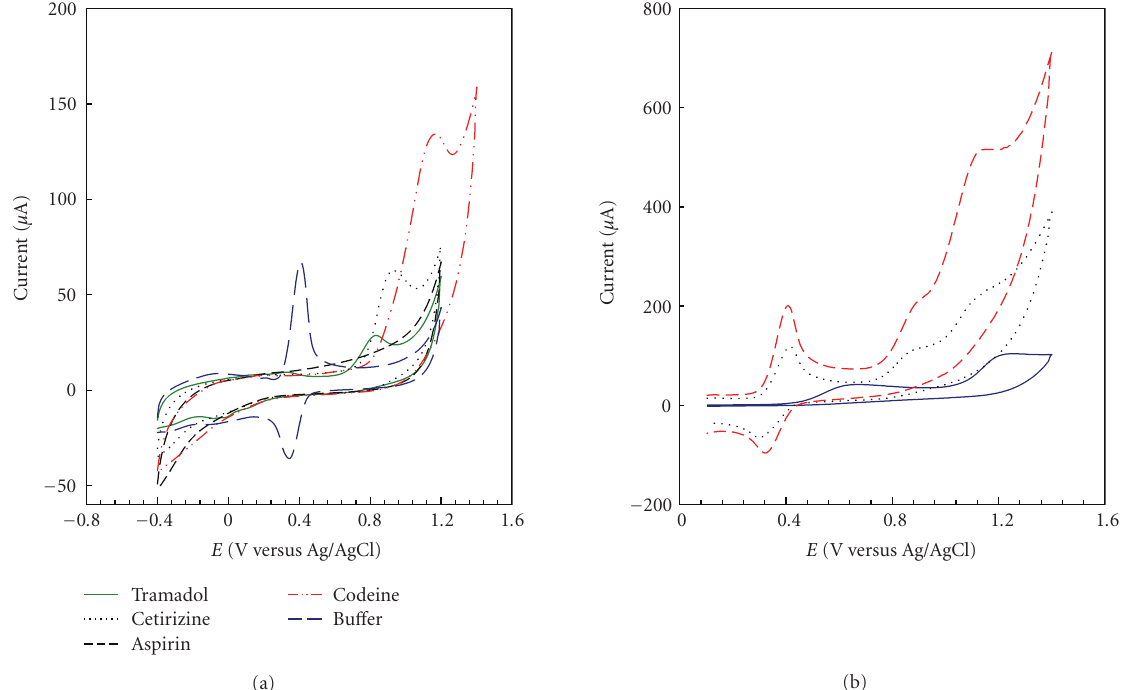
Figure 7: Cyclic voltammograms of (a) 0.1 mM of several drugs: tramadol, cetirzine, aspirin, codeine, and AC on the surface of oppy/MWCNT/GCE, (b) mixture solution containing 1mM of AA, AC, and codeine on the surface of bare GCE (solid line), CNT-GCE (dotted line), and oppy/MWCNT/GCE (dashed line). Supporting electrolyte was phosphate bu ff er solution of pH 7.0 and potential sweep rate was 100mVs − 1